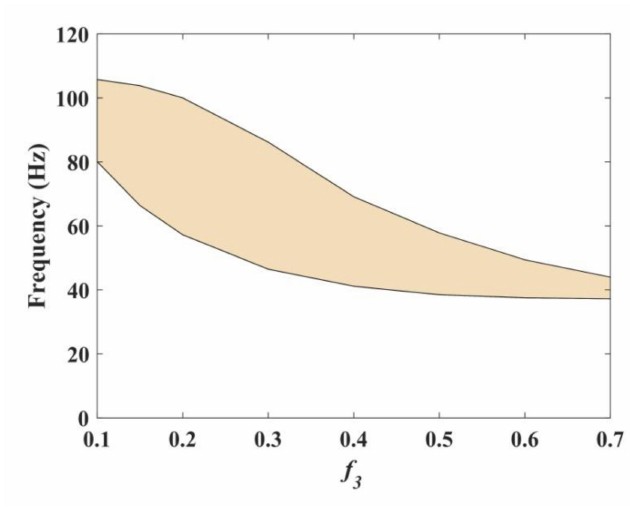
Figure 8. The influence of f 3 on the band gap.